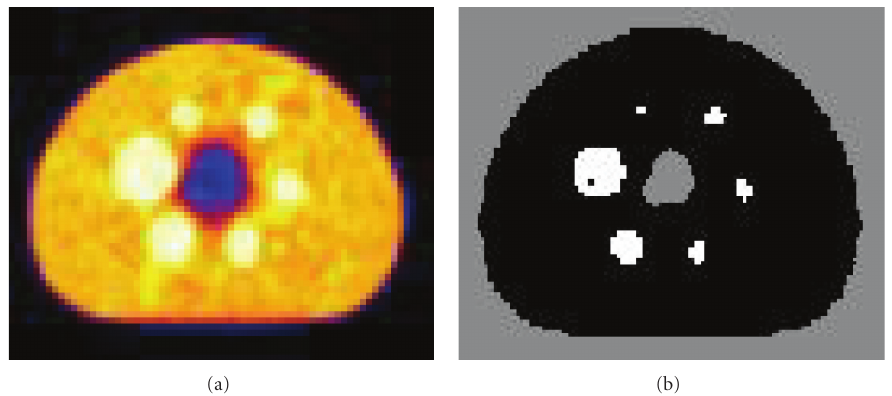
Figure 4: Experimental phantom data set: (a) original PET image and (b) classified image.